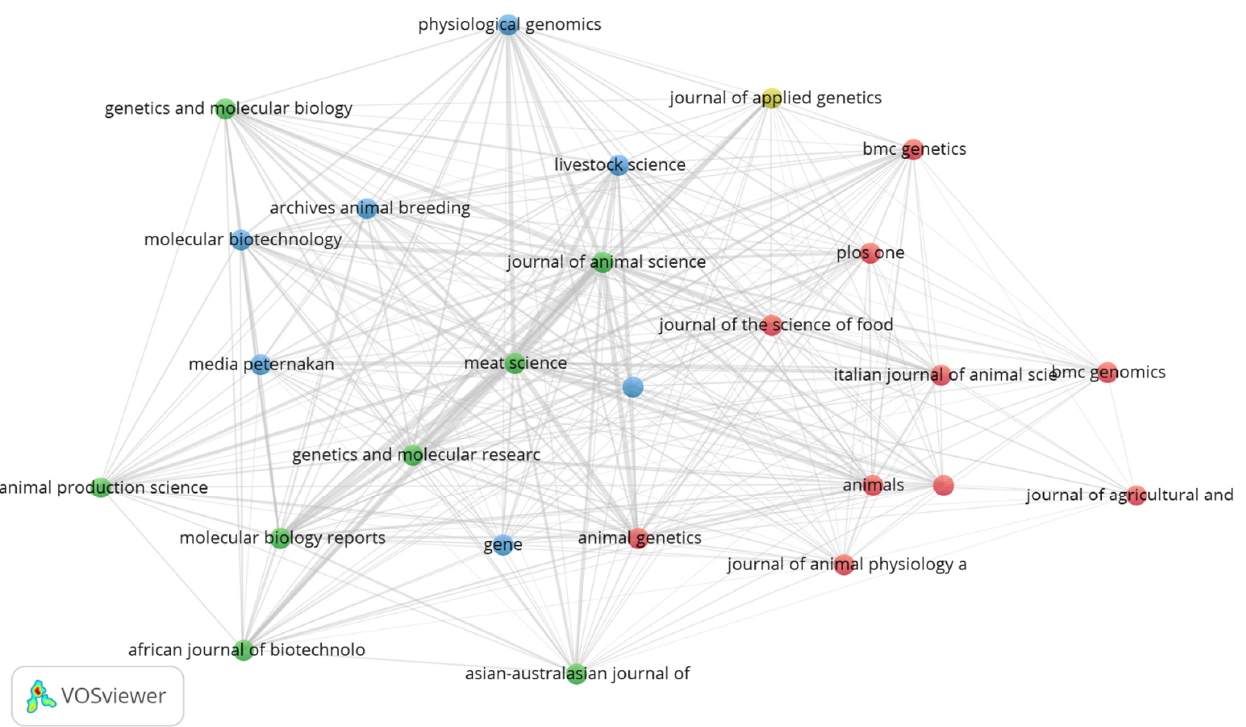
Figure 4. Bibliographic Coupling of journals with at least two papers.